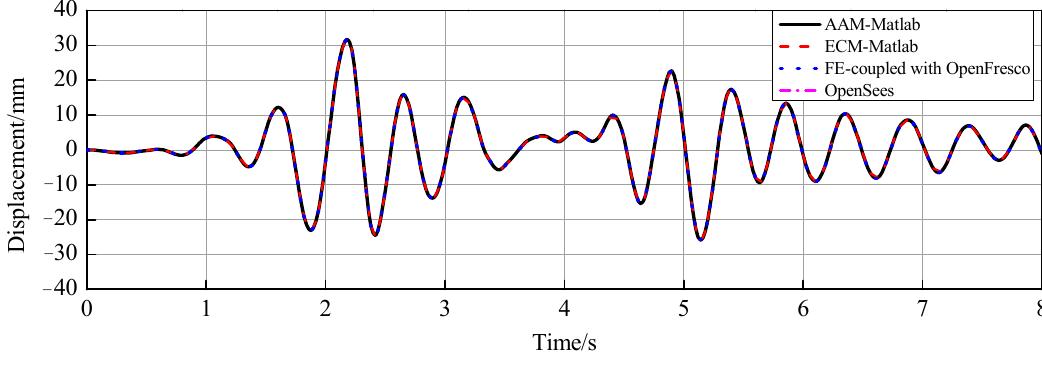
Figure 5. Displacement on top of column.